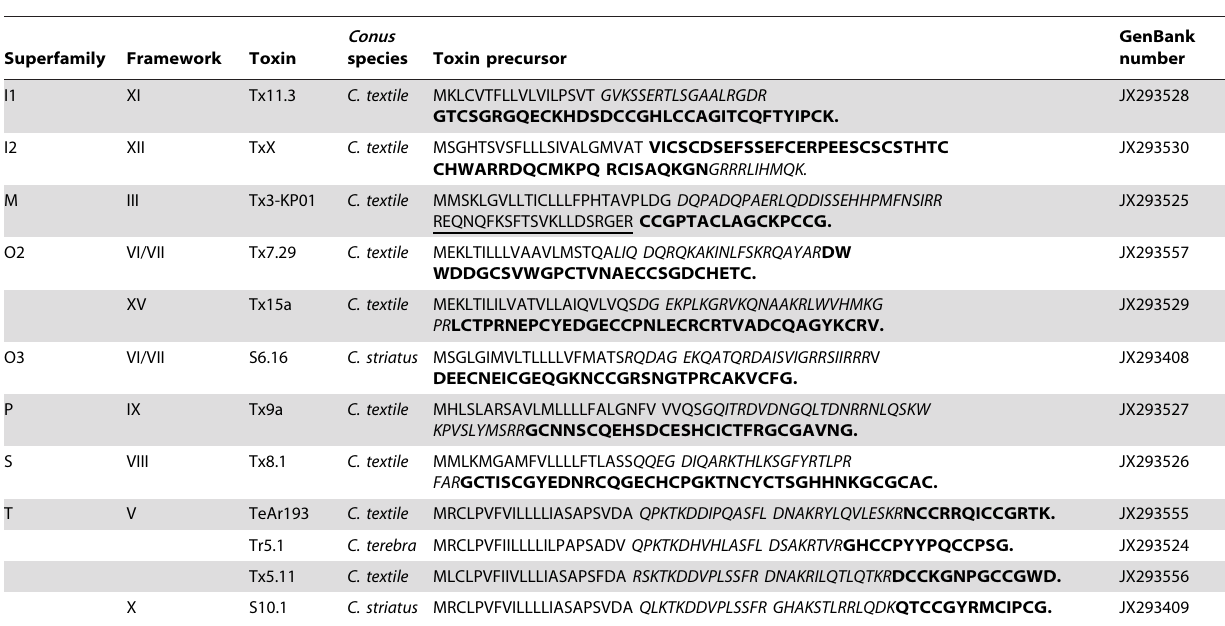
Table 1. Conotoxins selected for genome walking.